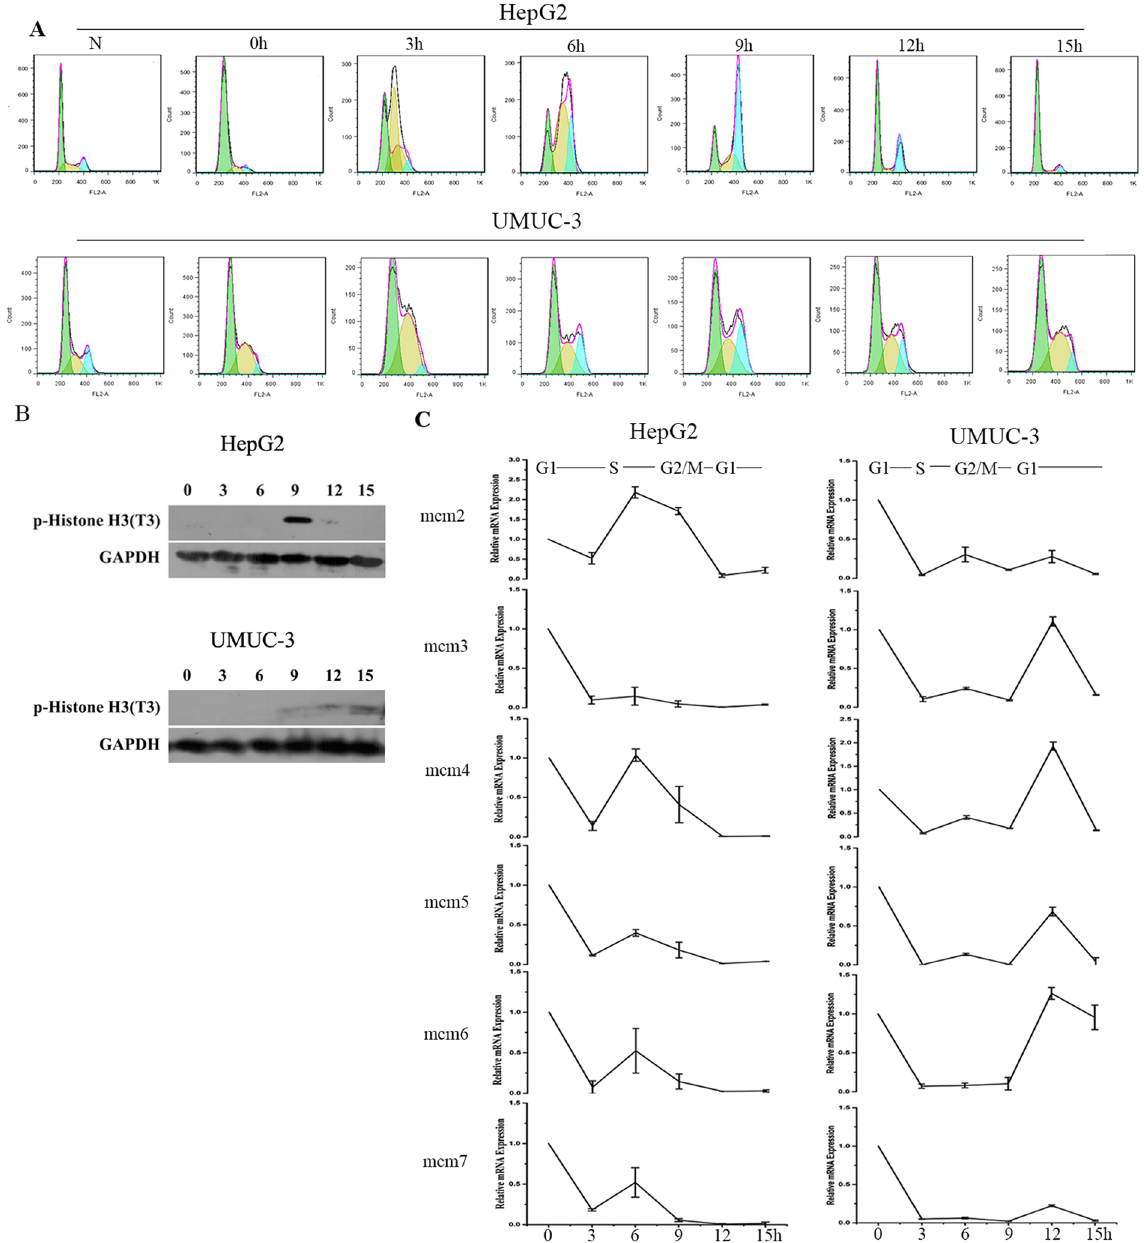
Figure 1. MCMs’ mRNA express in HepG2 and UMUC-3 Cells. ( A ) Cells were synchronized with double thymine and incubated in fresh medium for 0 h, 3 h, 6 h, 9 h, 12 h and 15 h. Cell cycle was analyzed by FACS. Data are shown as mean ± SD of three independent experiments. N: asynchronized cells. ( B ) P-Histone H3 was detected by western-blot. ( C ) MCMs’ mRNA levels were examined by real-time RCR. Data are normalized to the beta-actin level in each sample. These experiments were performed in triplicate, and the values are expressed as mean ±